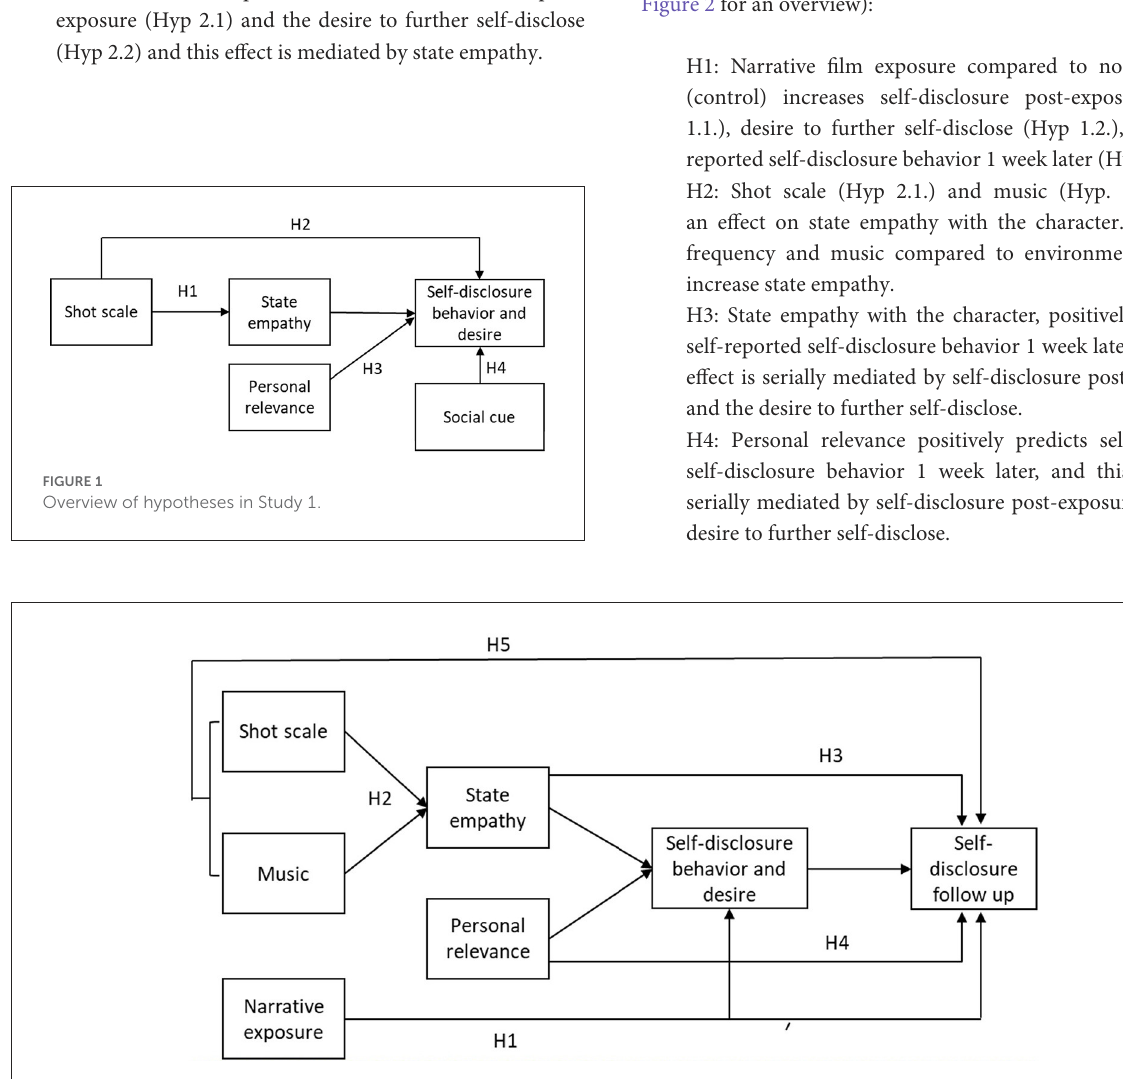
FIGURE2 Overview of hypotheses in Study